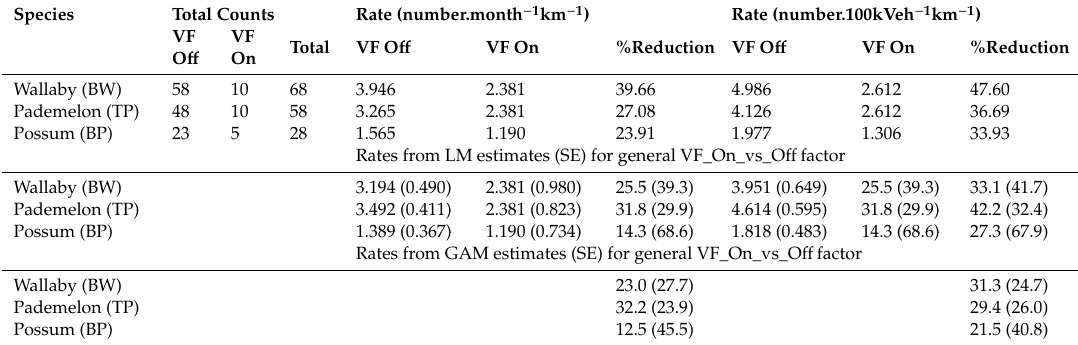
Table 2. Roadkill rates for three most prevalent roadkill species. Number killed for VF “On” versus “O ff ” and standardised rates using a general VF “On” vs “O ff ” factor / contrast estimated using all periods and Sections 2 to 7. Raw standardised rates and resultant percentage reduction based on total counts appear in the second, third, and fourth columns followed by model-based standardised rates and resultant percentage reductions with corresponding standard errors. For raw rates, the standardisation used total days of VF “On” apportioned by the fraction of sections switched on in Periods 3 and 5 and similarly for VF “O ff ”. Vehicle counts were similarly